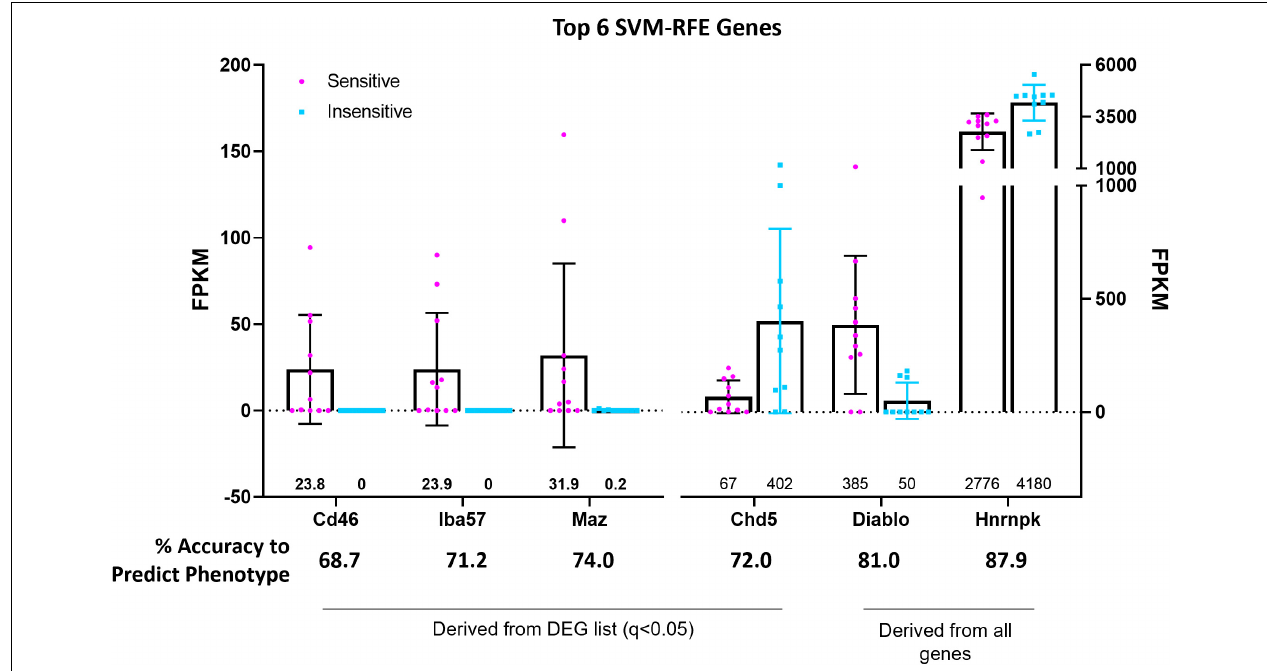
FIGURE 7 | Support vector machine, recursive feature elimination (SVM-RFE) analyses identified the genes CD46 , Iba57 , Chd5 , and Maz amongst 166 DEGs and the genes Hnrnpk and Diablo among all identified and sequenced genes as most accurate predictors of 5-HT neuron CO 2 sensitivity (sensitive vs.